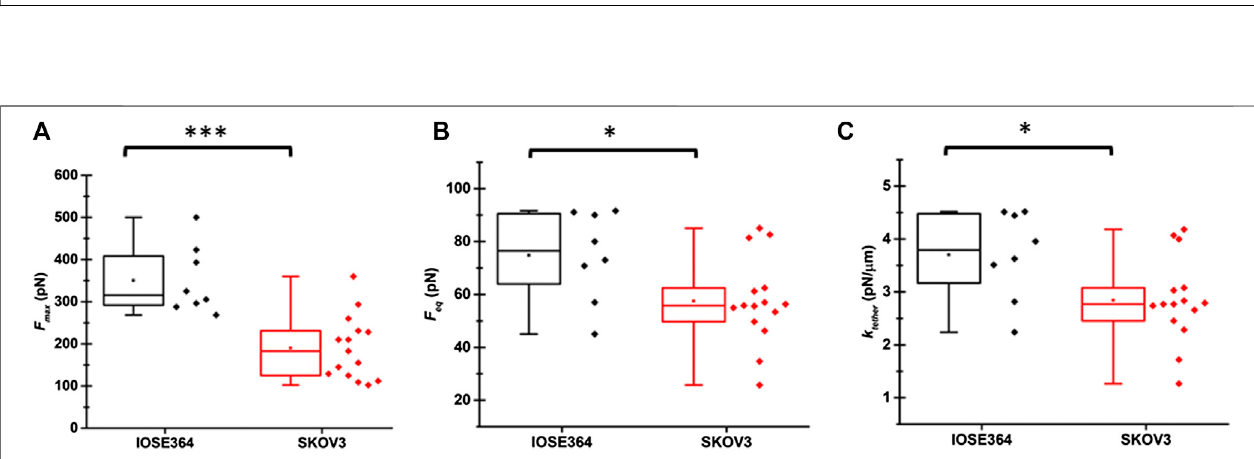
FIGURE 3 | Box-and-whisker plots of (A) F max , (B) F eq , and (C) k tether for tethers pulled from IOSE364 and SKOV3 cells. Individual values of the date are shown by blacksymbolsforIOSEtethers,andredsymbolsforSKOV3tethers.Numberoftetherswere8forIOSE364,and15forSKOVcells.Onetetherwaspulledfromeachcell. Asterisks *, and *** indicate statistically signi fi cant differences at p < 0.05, and p < 0.001, respectively. The speci fi c values are p (cid:1) 0.0004 (A) , p (cid:1) 0.034 (B) , and p (cid:1) 0.032 (C) .